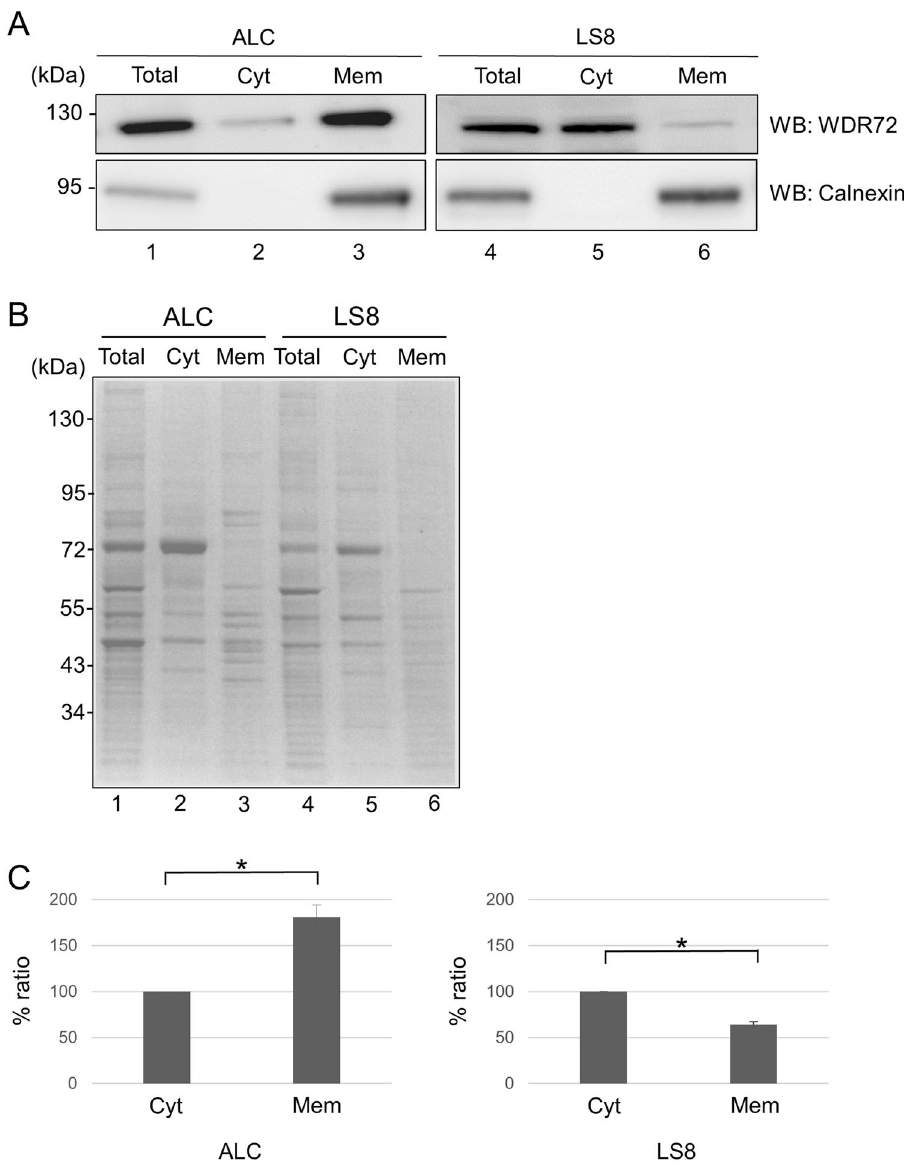
Figure 3. Expression of WDR72 at the cytosolic and membranous fractions in ameloblasts. ( A ) ALC and LS8 cell lysates were fractionated into total cell homogenate (Total), cytosolic fraction (Cyt) and membranous fraction (Mem). Western blot analysis was performed and the expression of WDR72 using these fractions was investigated in both ALC and LS8 cells (upper panels). The successful separation of the membranous fraction from the cytosolic fraction was verified by Western blot analysis with anti-Calnexin antibody (lower panels). The experiment was repeated three times and representative images are shown. ( B ) The equal quantity of extracted protein extracts from each fraction in both ALC and LS8 cells were resolved by 4–12% SDS-PAGE and subjected to Coomassie Brilliant Blue staining. ( C ) The band intensities of cytosolic and membranous fractions immunoreactive to anti-WDR72 antibody in ALC and LS8 cells were measured. The % ratio of the intensities from three different experiments was calculated and the mean values with ± SD are shown. The asterisks show that there was a statistically significant difference between WDR72 protein expression in the cytosolic and membranous fractions (p <